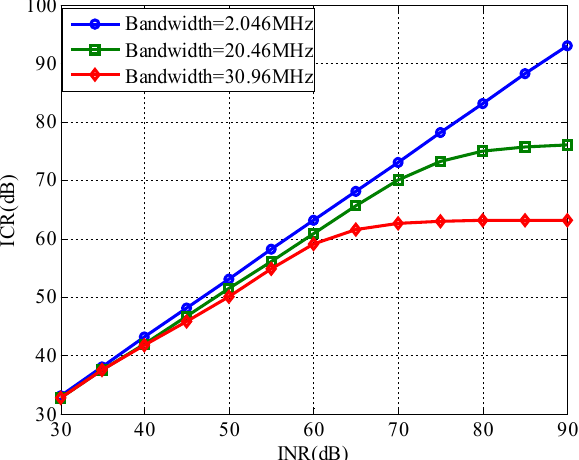
Figure 11. ICR for different bandwidths with jammer multipath.